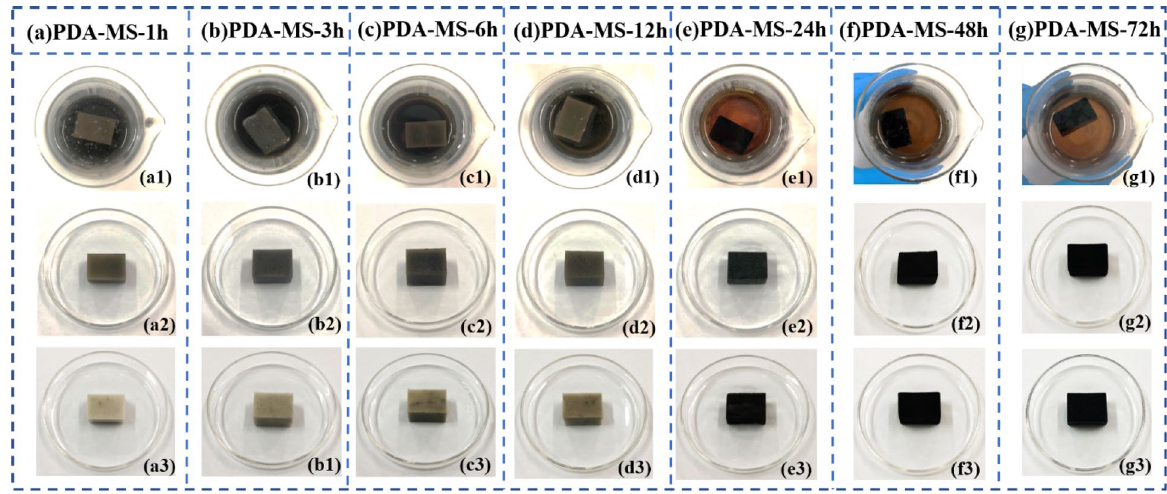
Figure 10. ( a1 – g1 ) the different MS dipped in PDA suspension after polymerized for 1–72 h; ( a2 – g2 ) Color of PDA-MS-1 h to PDA-MS-72 h after polymerization for 1 h-72 h; ( a3 – g3 ) Color of PDA-MS-1 h to PDA-MS-72 h after extruded the excess PDA